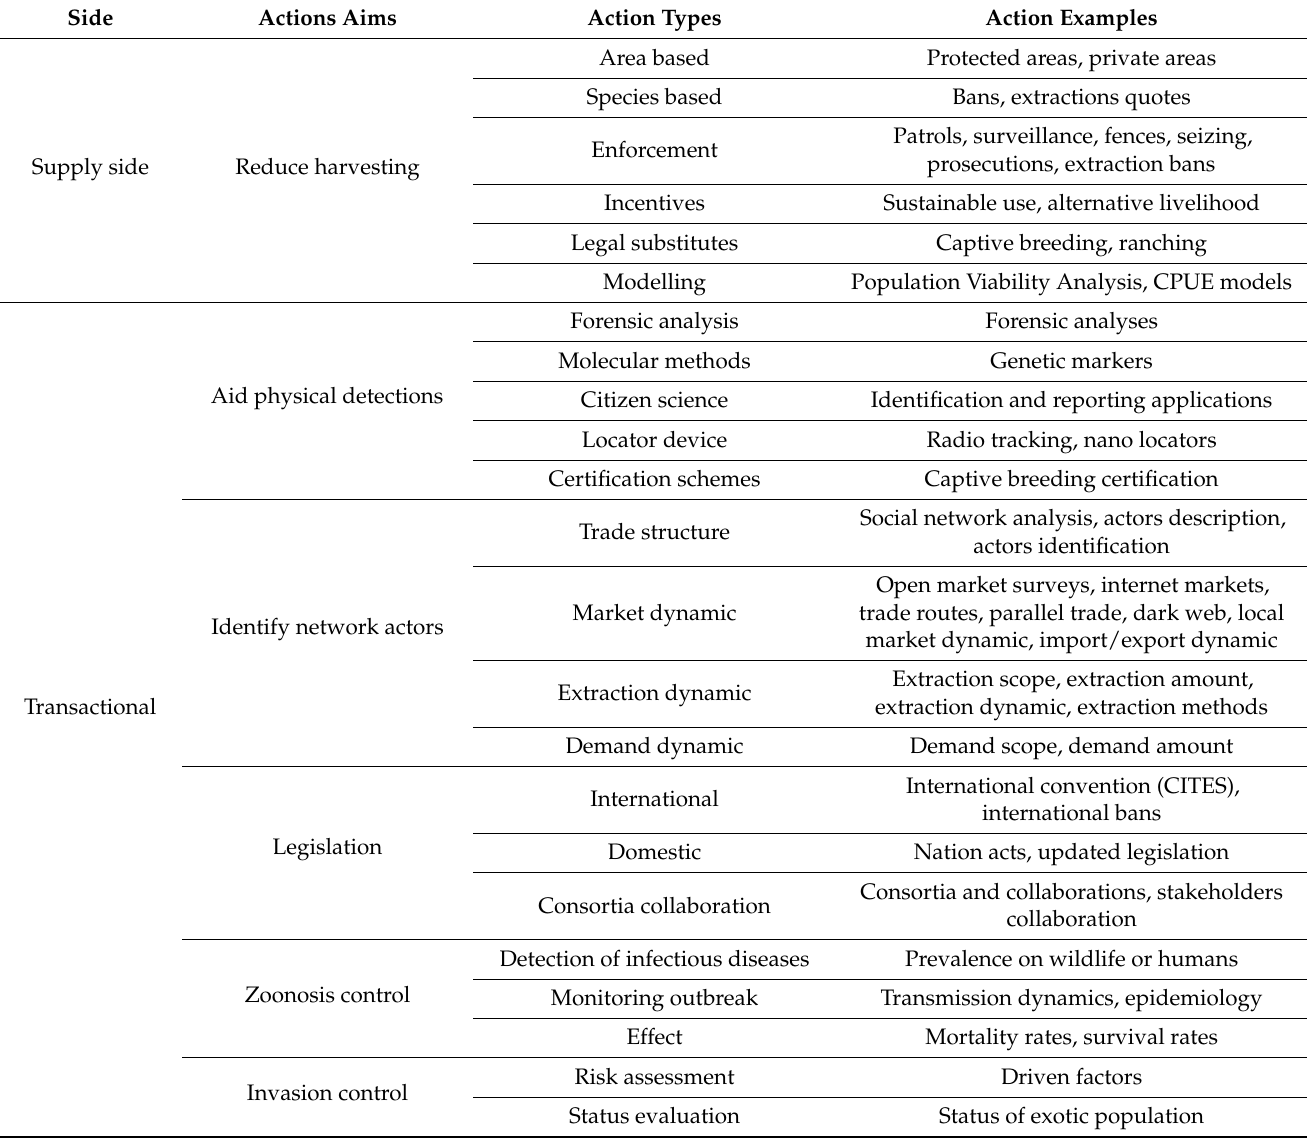
Table 1. Illegal wildlife trade mitigation measures scheme used to classify published research about the illegal parrot trade. Side Actions